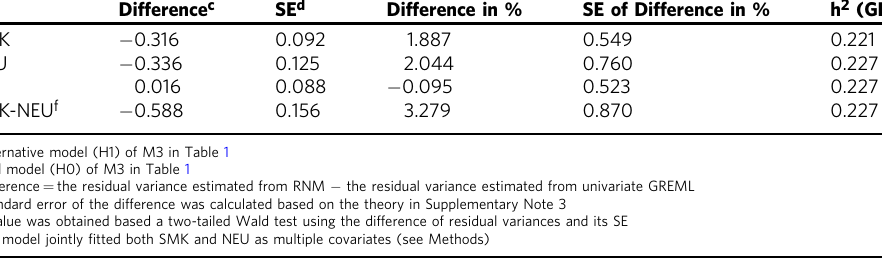
Table 2 The difference between residual variances of BMI estimated from RNM a and GREML b Difference c SE d